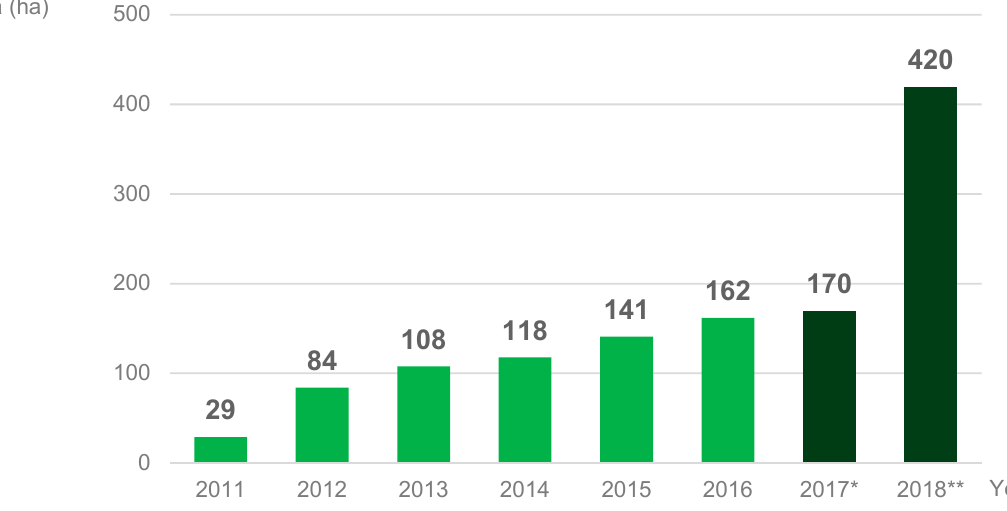
Figure 1. Changes in urban agriculture area in Seoul between 2011 and 2018. Notes: * Revised estimate; ** Target set in Seoul Urban Agriculture Vision II [38].